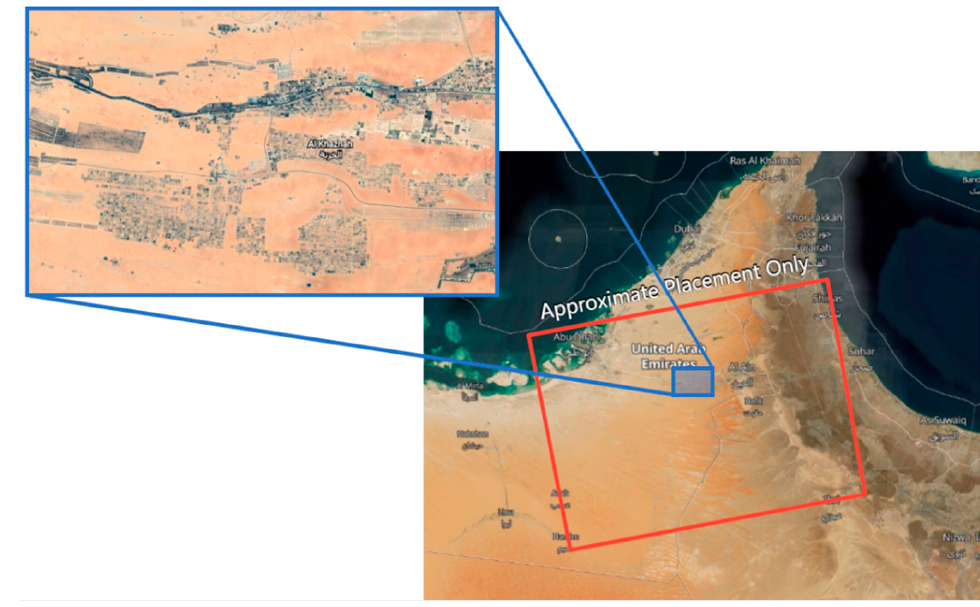
Figure 8. The baseline configuration of the used data set.